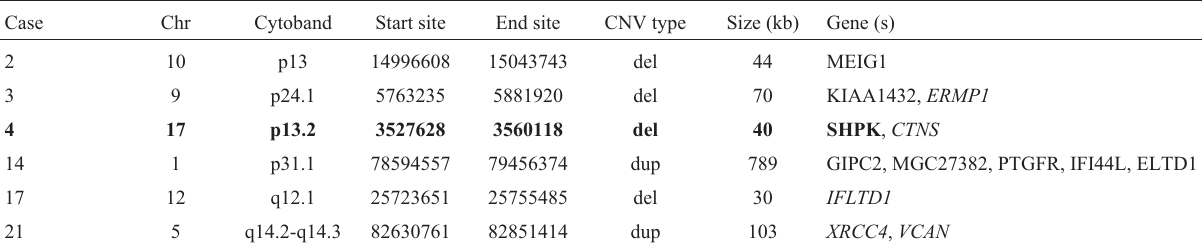
Table 2 - Descriptions of all rare copy number variations identified in the individuals with Argyrophilic grain